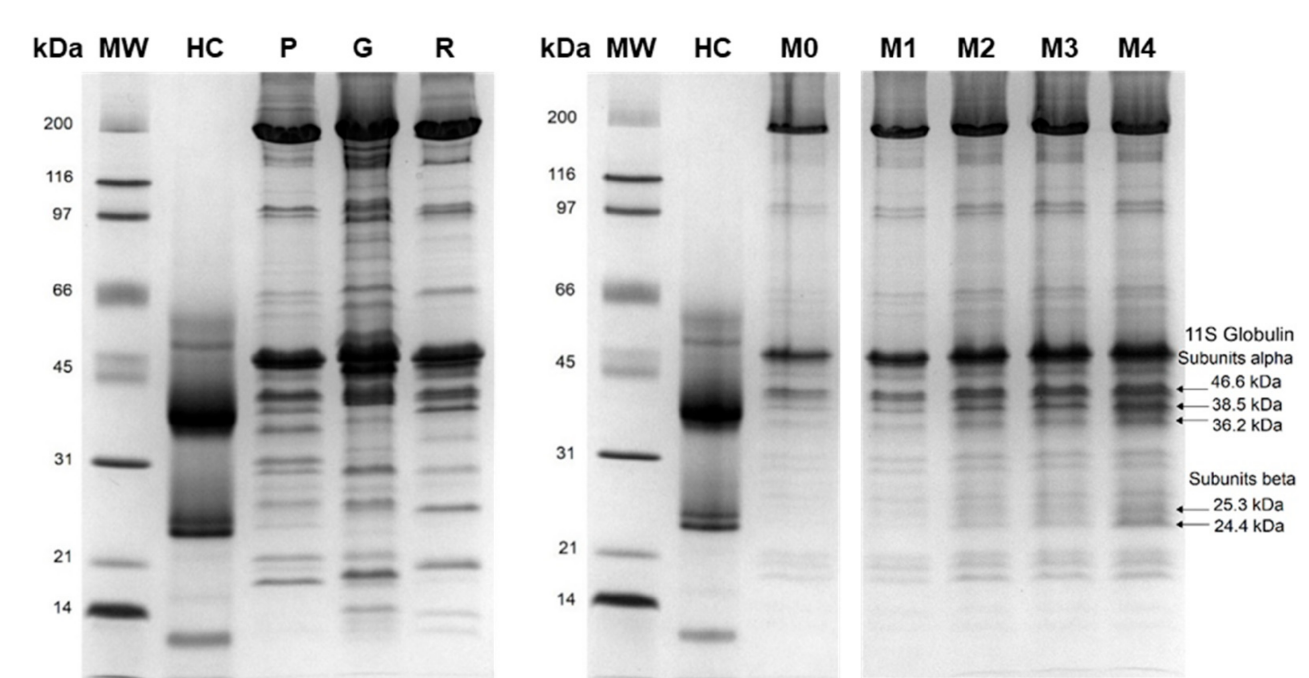
Figure 1. Comparison of protein profiles extracted from hemp cake, raw meat samples, and cooked meatball variants. Arrows show bands derived from hemp storage protein alpha and beta subunits detected in cooked meatballs. Lanes: HC—hemp cake; P—pork; G—guinea fowl meat; R—rabbit meat; M0—control meatball without hemp cake addition; M1, M2, M3, M4—meatballs with increasing content of hemp cake, i.e., 0.9%, 2.6%, 4.2% and 7.4%,